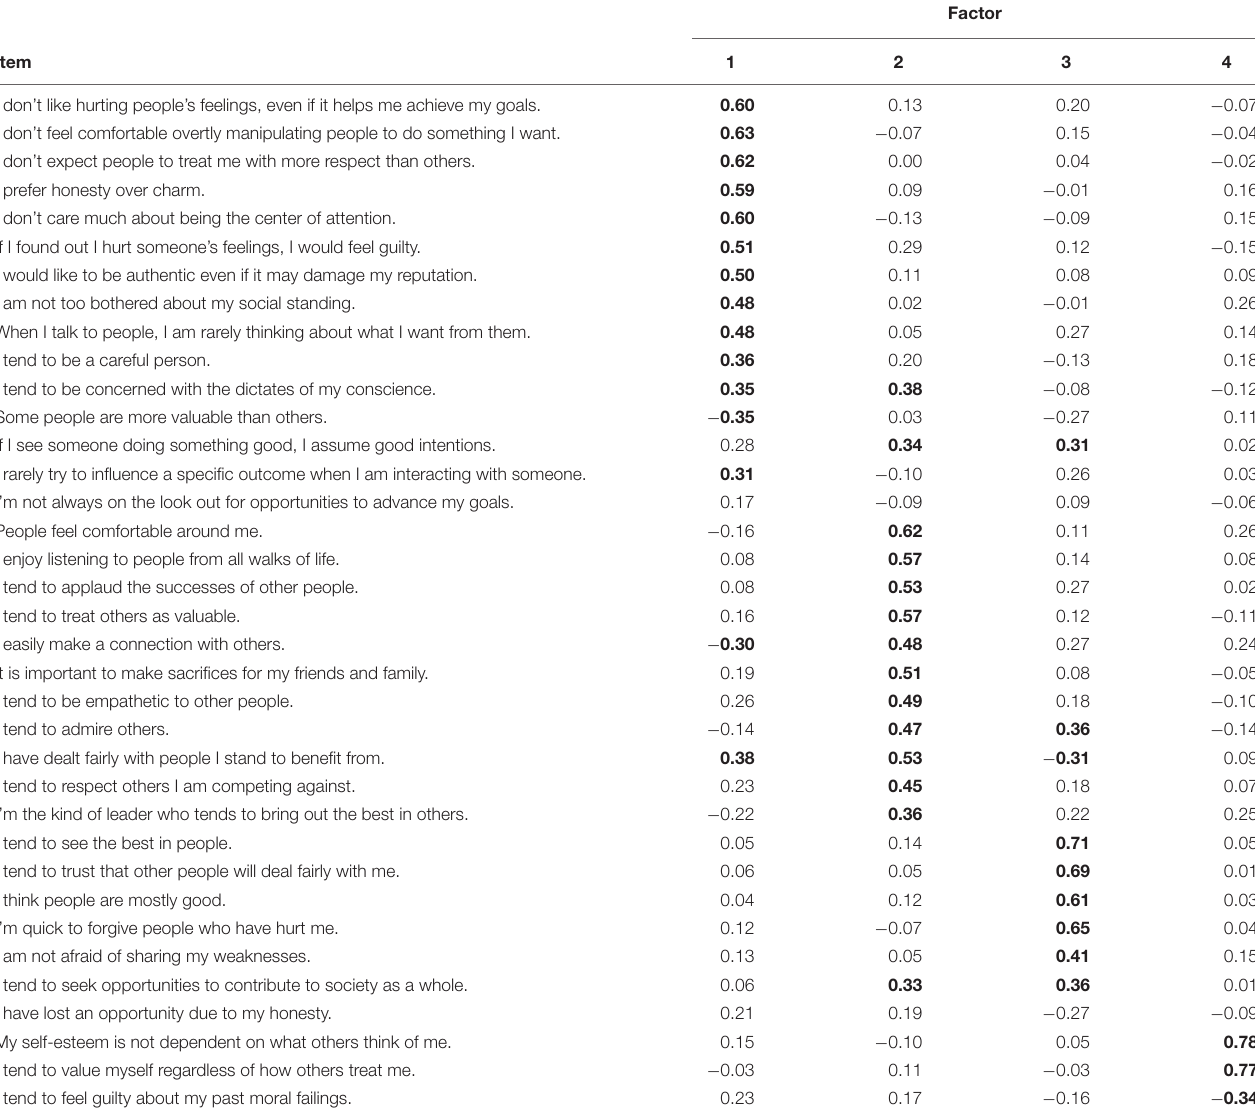
TABLE 2 | Exploratory factor analysis loadings from the initial 36 light triad items in study 1.